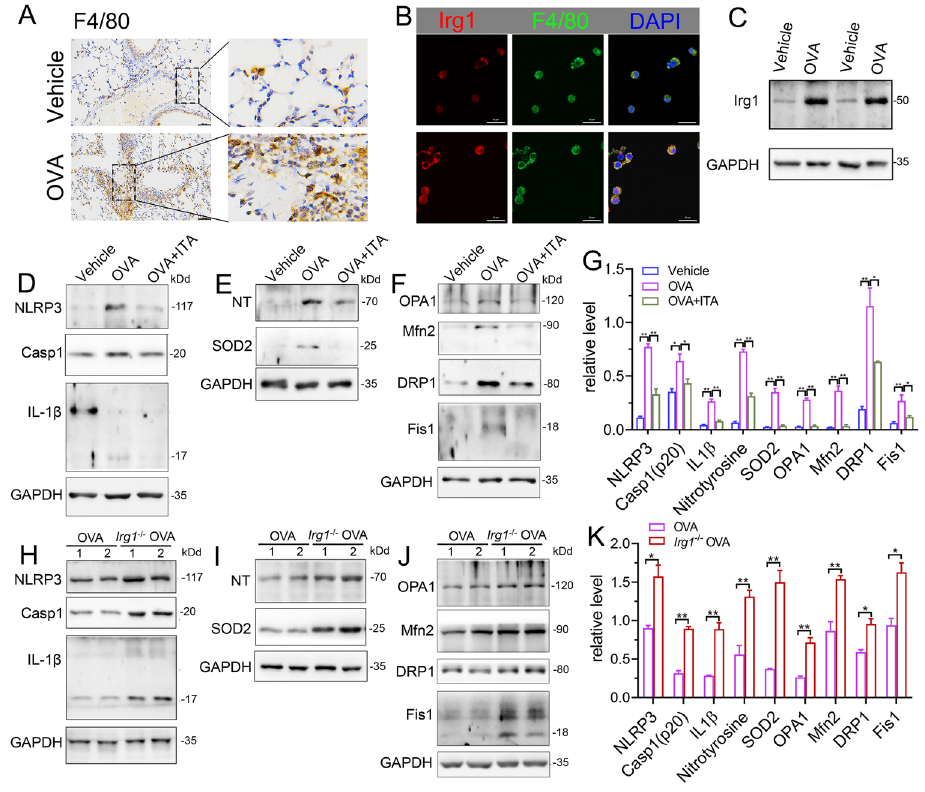
Figure 7. Itaconate inhibits the activation of NLRP3 inflammasome, oxidative stress and mitochondrial fusion/fission in BALF alveolar macrophages. ( A ) Representative lung sections of the immuno- histologic staining of F4/80 in vehicle and OVA mice; scale bar: 50 µm. ( B ) Representative double immunofluorescent staining of F4/80 and Irg1 in BALF AMs from vehicle and OVA group. Scale bar: 20 µm. ( C ) Representative blots of Irg1 in BALF AMs from vehicle and OVA mice. ( D ) Repre- sentative blots of NLPR3, Caspase-1 (p20) and IL- 1β (p17) in BALF AMs from vehicle, OVA and OVA+ITA mice. ( E ) Representative blots of nitrotyrosine (NT) and SOD2 in BALF AMs from vehicle, OVA and OVA+ITA mice. ( F ) Representative blots of OPA1, Mfn2, DRP1 and Fis1 in BALF AMs from vehicle, OVA and OVA+ITA mice. ( G ) Quantitative analysis of NLPR3, Caspase-1 (p20), IL- 1β (p17), nitrotyrosine (NT), SOD2, OPA1, Mfn2, DRP1 and Fis1 in AMs from vehicle, OVA and OVA+ITA group. ( H ) Representative blots of NLPR3, Caspase-1 (p20) and IL- 1β (p17) in BALF AMs from OVA and Irg1 −/− OVA mice. ( I ) Representative blots of nitrotyrosine (NT) and SOD2 in BALF AMs from OVA and Irg1 −/− OVA mice. ( J ) Representative blots of OPA1, Mfn2, DRP1 and Fis1 in BALF AMs from OVA and Irg1 −/− OVA mice. ( K ) Quantitative analysis of NLPR3, Caspase-1 (p20), IL- 1β (p17), nitrotyrosine (NT), SOD2, OPA1, Mfn2, DRP1 and Fis1 in AMs from vehicle, OVA and OVA+ITA group. For Western blot, n = 3 per group, each replicate pooled cells from three to five mice in vehicle and OVA+ITA group, while in OVA and Irg1 −/− OVA group, each replicate repre- sented one mouse; before seeding, the cell number was counted to ensure that the adherent AMs number will be no less than 2.5 × 10 5 cells/well. Cropped blots are shown, and Supplementary File S2: Figures S13–S23 presents the full-length blots. * p < 0.05, ** p < 0.01.